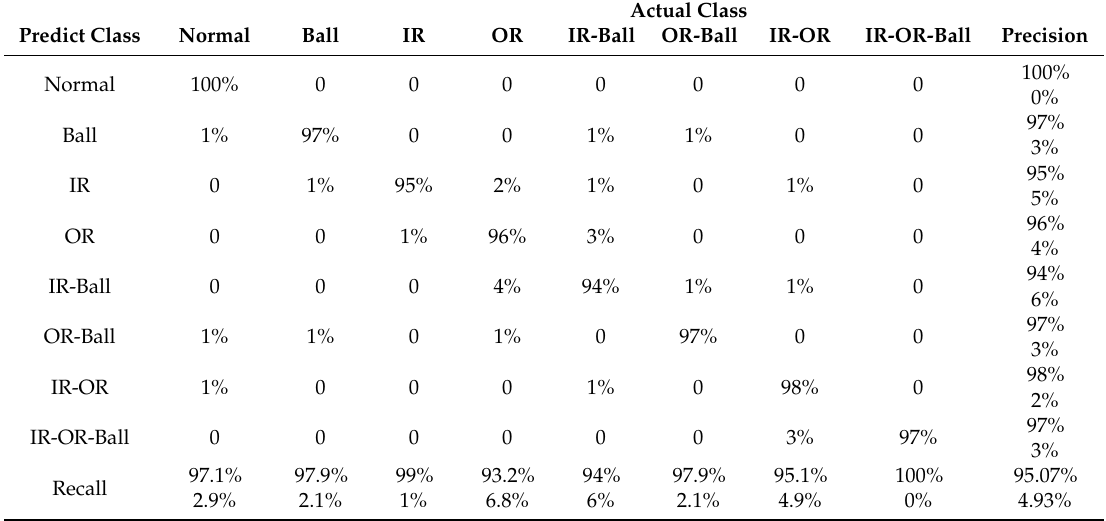
Table 6. Confusion matrix using dataset 2 with the proposed method when the torque speed is 400 RPM and the crack size is 3 mm.